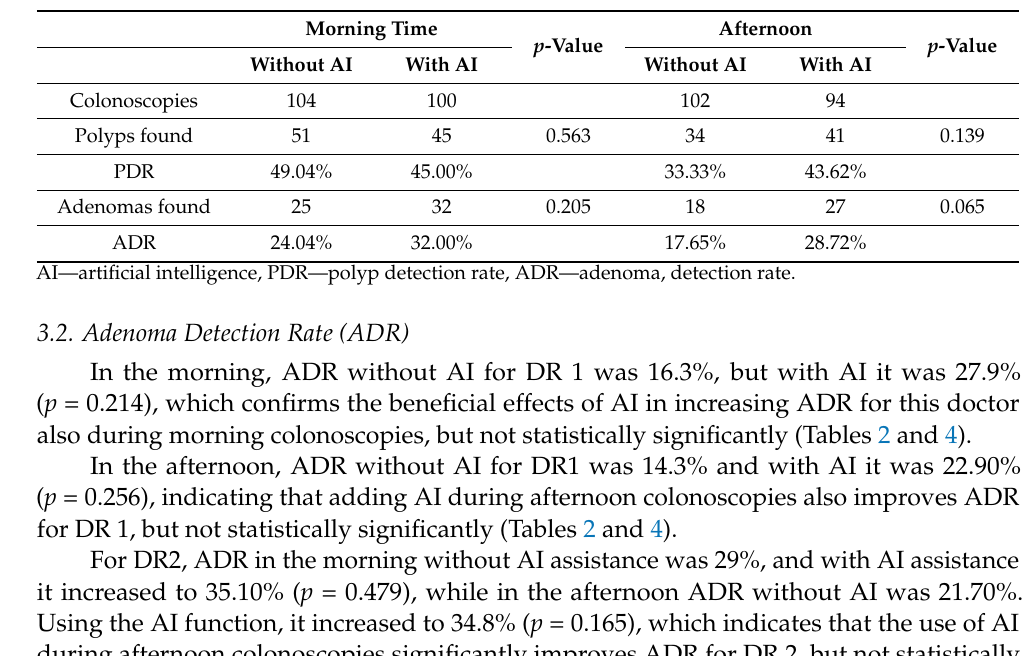
Table 4. The results of the examinations performed by both